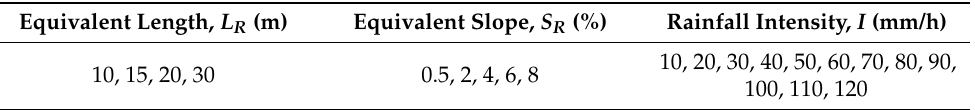
Table 1. Analysis